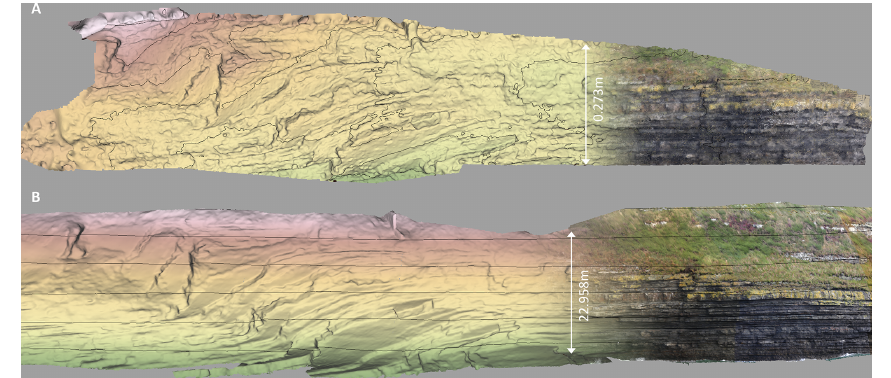
Figure 4. Virtual outcrop model of Kilcredaun, Ireland (Kilcredaun, VOG Group, https://v3geo.com/model/67, last access: 7 March 2022, CC BY-NC). (a) 3D model processed without georeferencing by students during classroom exercise: scale and orientation of the model are incorrect (0.05m contours). (b) Final model in V3Geo (5m contours). Models coloured by elevation (white is high, through to green, low).